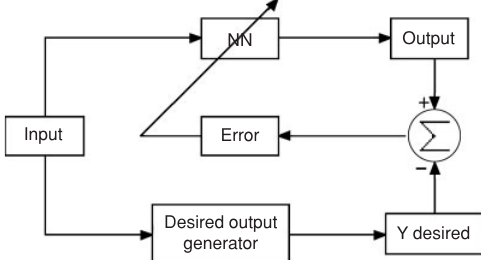
Figure 2 Supervised learning.